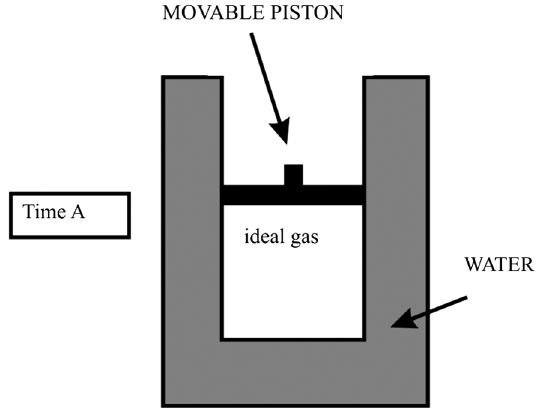
FIG. 3. Ideal gas in a sealed metal cylinder surrounded by a water container.